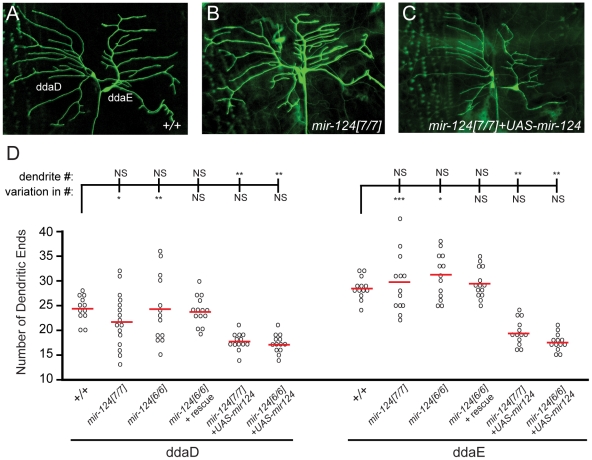

mir-124 suppresses variation in dendrite numbers on sensory neurons.(A–C) We labeled ddaD and ddaE neurons with CD8-GFP under the control of Gal4221. Representative images are shown from mir-124 loss- and gain-of-function backgrounds. The overall patterns of dendrite branching in wildtype (A) and mutant (B) were similar. (C) Misexpression of mir-124 in the mir-124 mutant strongly decreased the complexity of dendritic branching. (D) Quantitative analysis. Each of the circles represents dendrite quantification of an individual neuron. Although the average numbers of dendritic ends for ddaD and ddaE neurons in mir-124[6] or mir-124[7] mutants were not statistically different those in wildtype, the variation in their numbers was significantly increased (by F test). The effect was more pronounced in ddaD than ddaE neurons, but both were rescued by the mir-124 genomic transgene. Analysis of mir-124 overexpression in the mir-124 mutant background showed a strong decrease in branching complexity; still, the variation in dendritic end numbers was rescued.